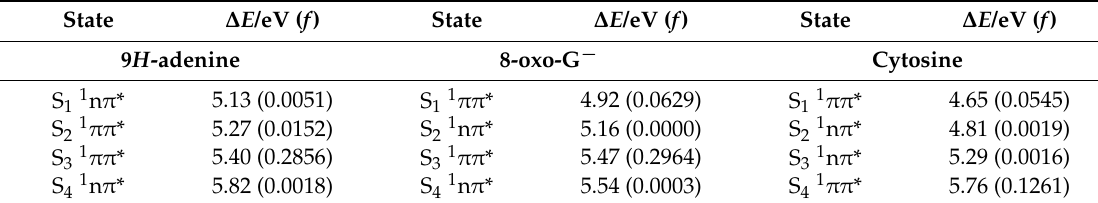
Table 2. Vertical excitation energies ( ∆ E ) and oscillator strengths ( f ) of the lowest four excited states of isolated 9 H -adenine, anionic 8-oxo-guanine, and cytosine, calculated at the ADC(2)/cc-pVDZ level of